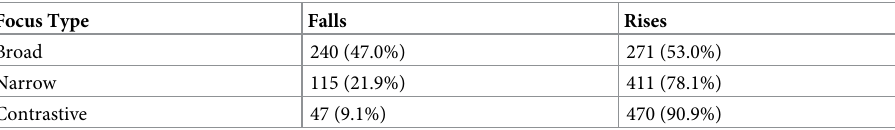
Table 2. Numbers and proportions of falls and rises in the three focus